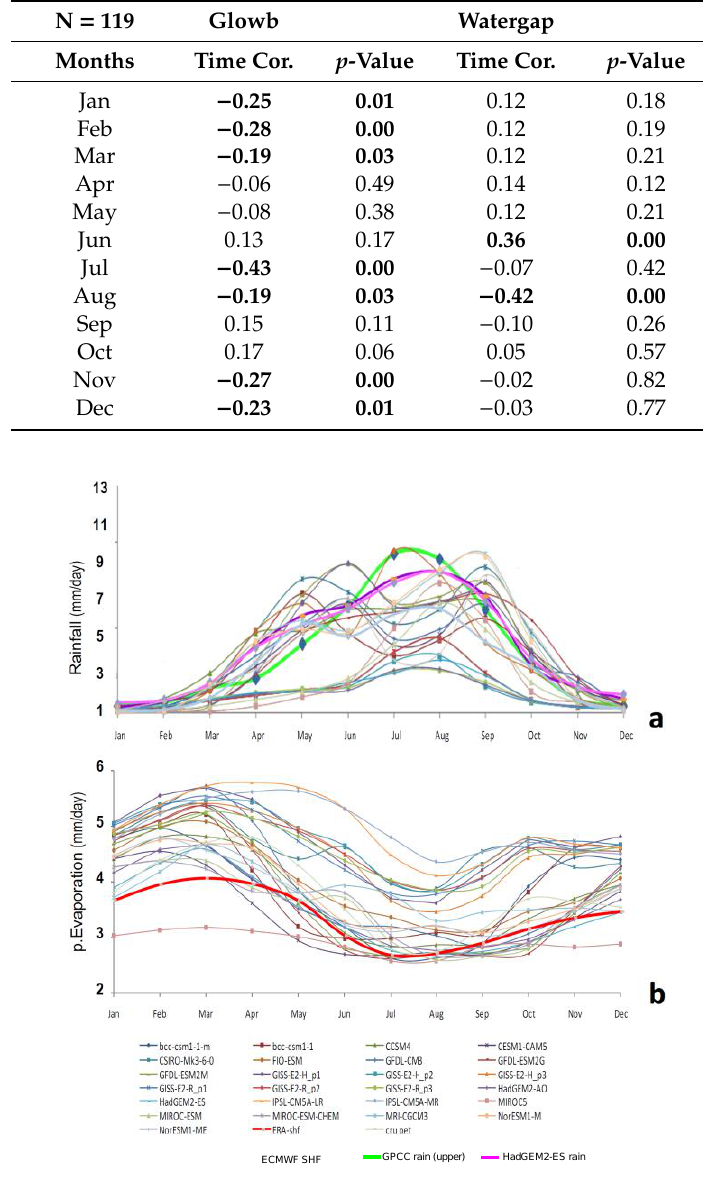
Figure A2. ( a ) Scatterplot of elevation vs. Jul – Oct surface T across Ethiopia, arrow highlights the most suitable range, ( b ) main crop-growing areas (green shaded). ( c ) Example of LGP constraints imposed by thresholds of daily soil moisture and minimum T. Note the drought in 2015 and higher T in 2017 – 2018. The min. T is trimmed above 16C to indicate no threshold exceedance.